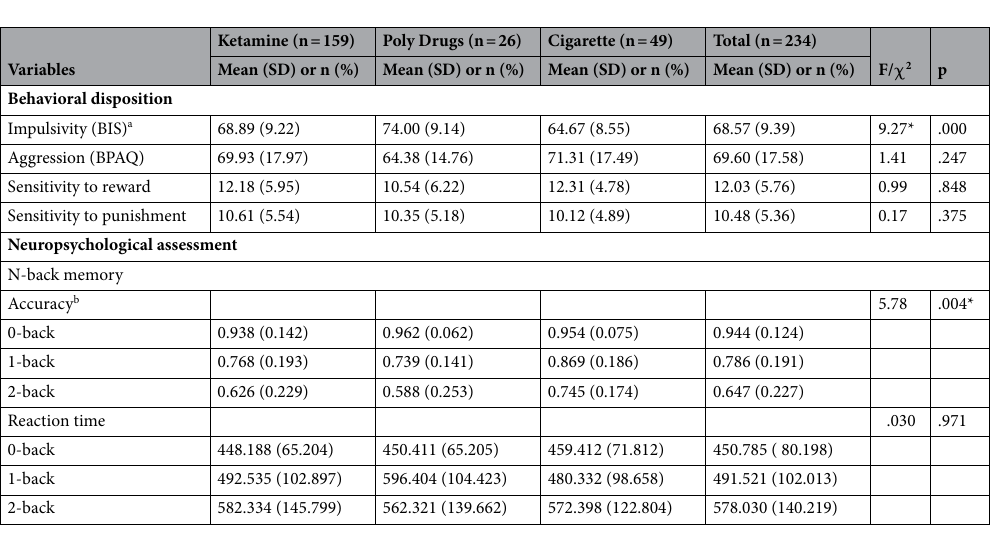
Table 3. Behavioral dispositions and short term memory performance of participants. Bonferroni correction was used to adjust multiple comparisons. Tukey’s method was performed to test the post-hoc difference. * p < .05/10 = .005. a Polydrugs > Ketamine > Cigarette. b Cigarette > Polydrugs,